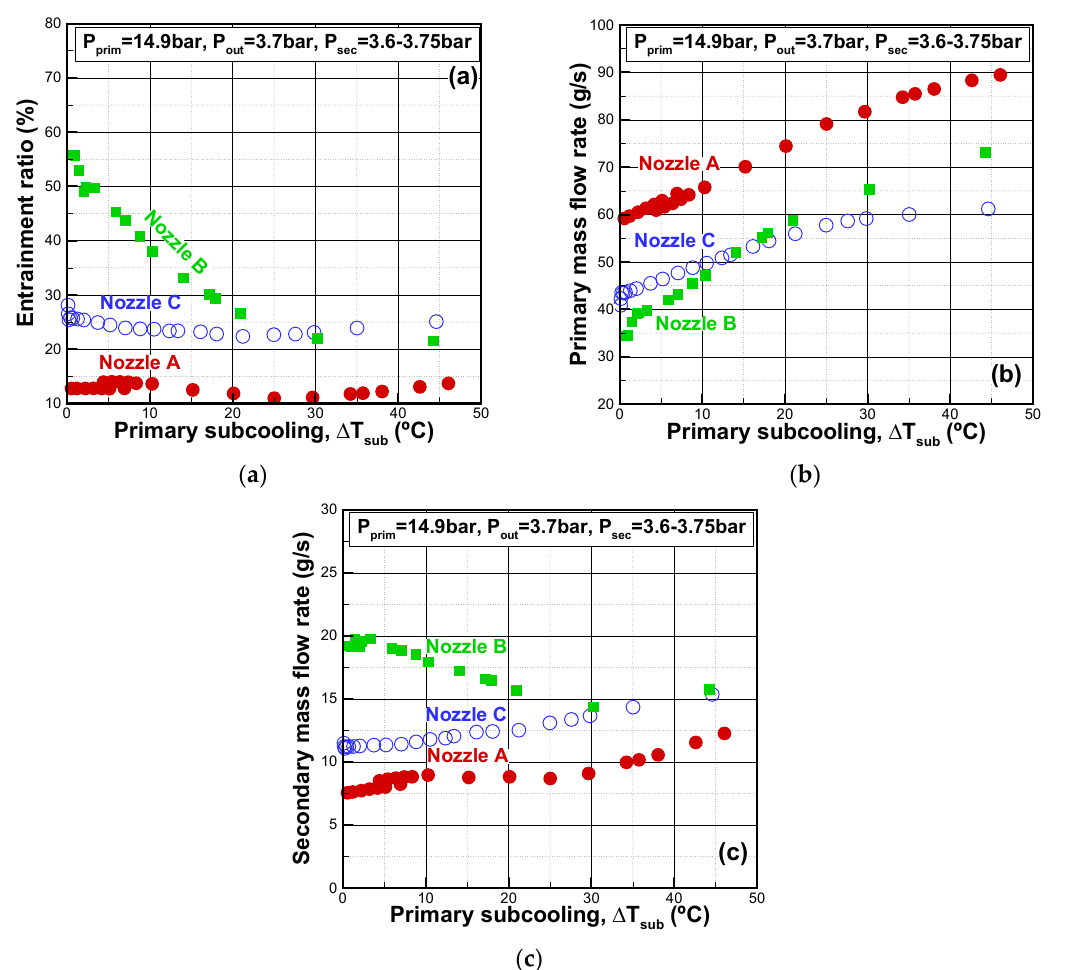
Figure 9. Nozzle geometries and the primary inlet subcooling: ( a ) Entrainment ratio; ( b ) Primary mass flow rate; ( c ) Secondary mass flow rate.